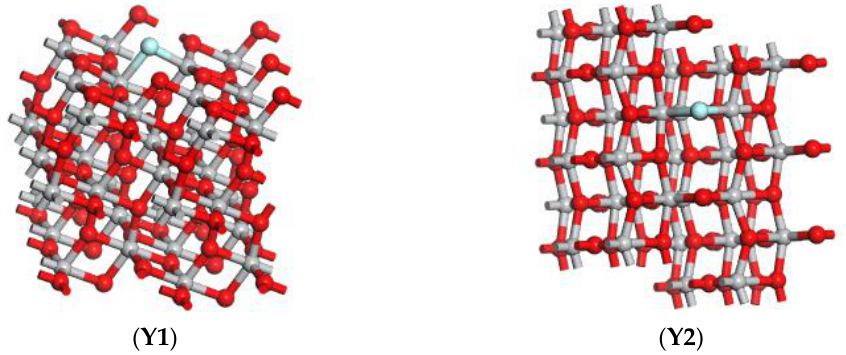
Figure 2. F-doped TiO 2 model, ( Y1 ) is the main view of the model, and ( Y2 ) is the top view of the model.